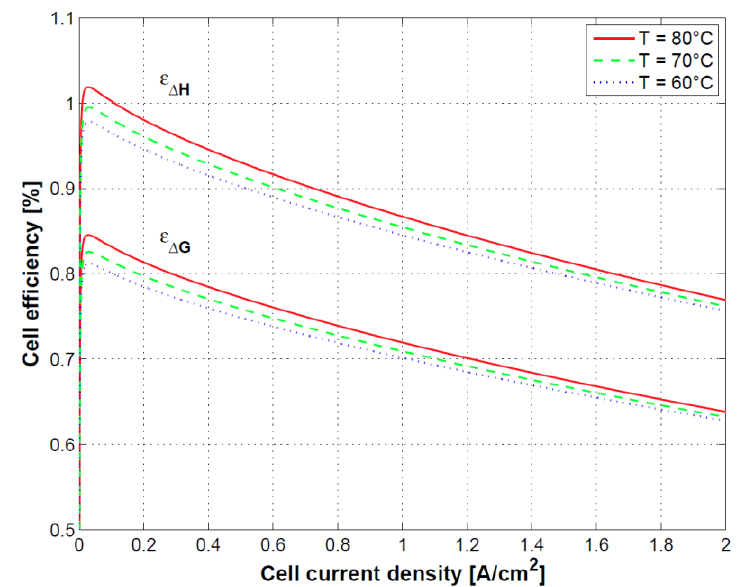
Figure 11. Cell efficiency curve along different current densities.